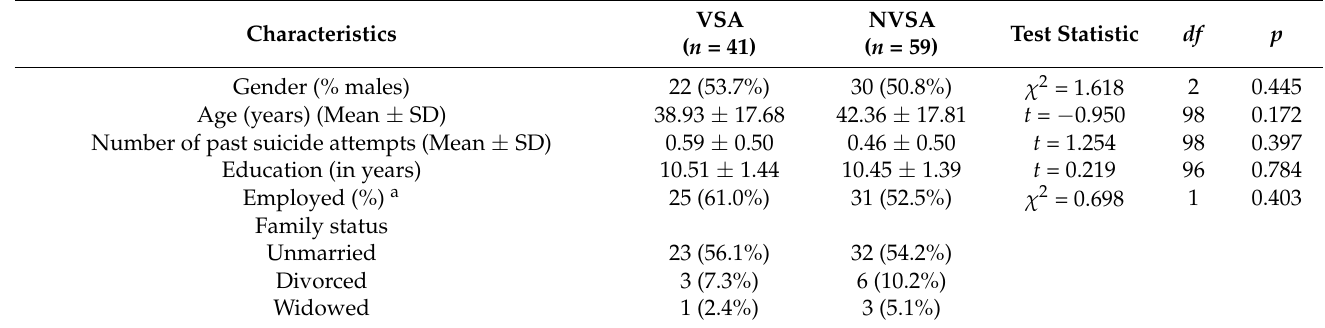
Table 1. Comparison of sociodemographic and clinical characteristics between suicide